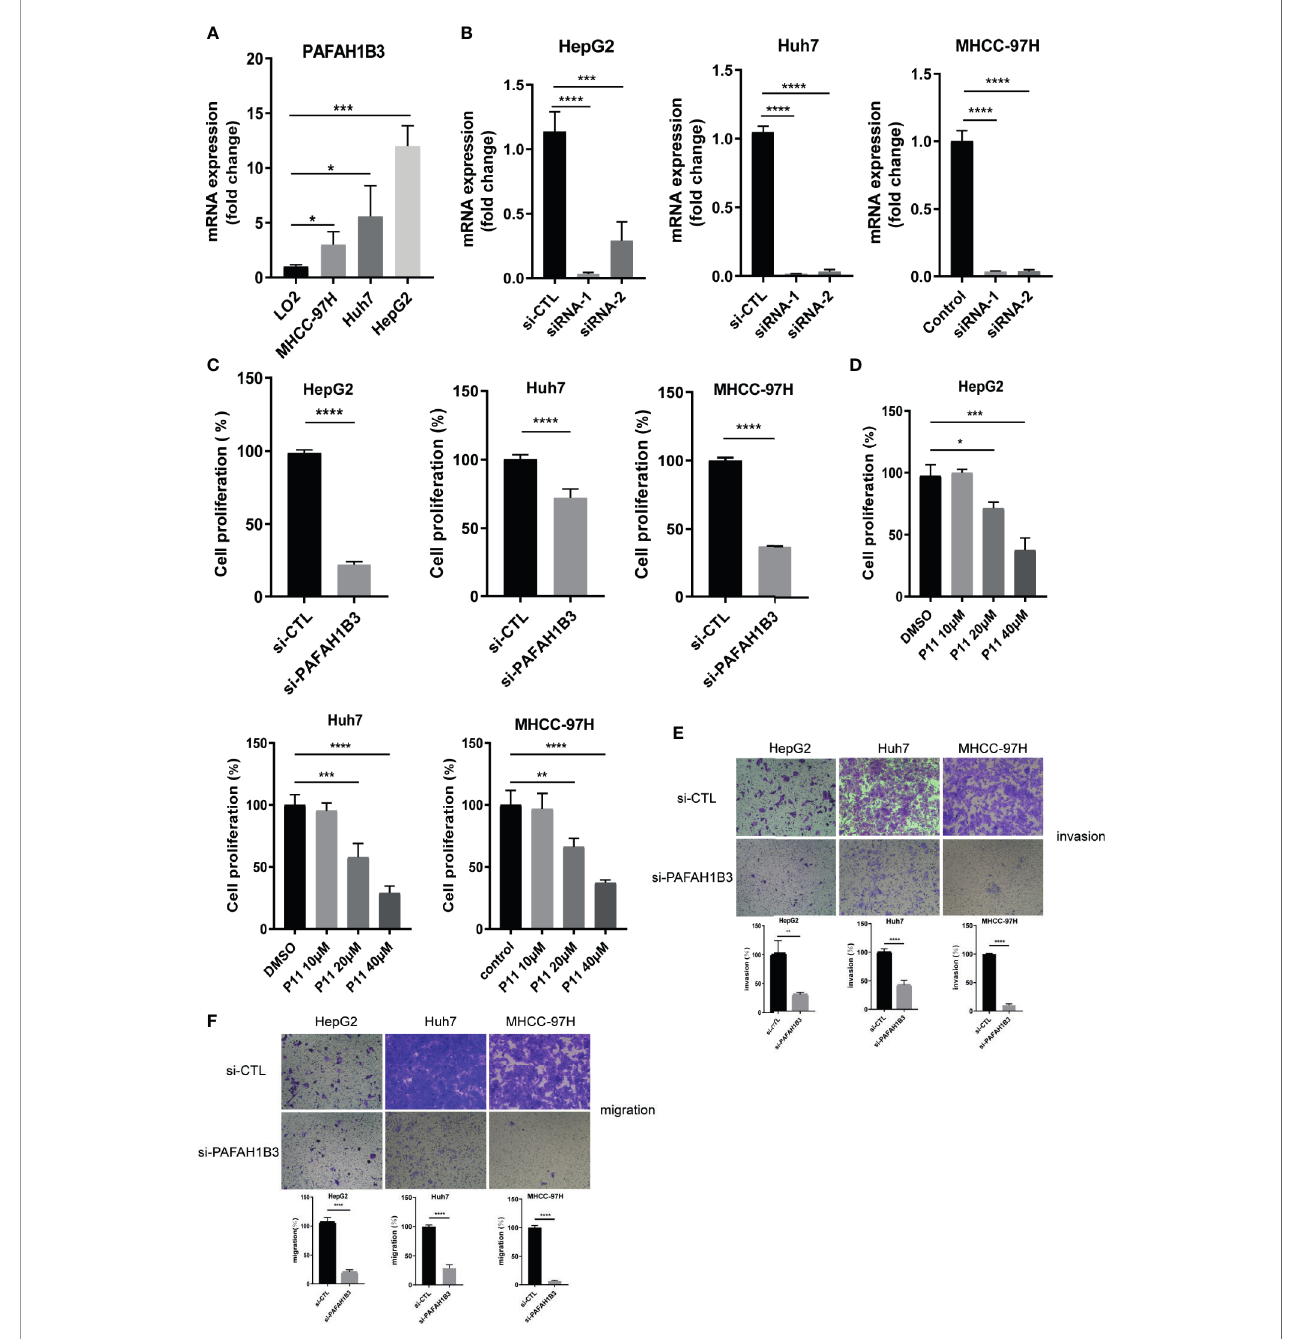
FIGURE 4 | High expression of PAFAH1B3 related to the proliferation and metastasis of HCC cells. (A) Levels of PAFAH1B3 mRNA in LO2, MHCC-97H, Huh7, and HepG2 cell lines. (B) Quantitation of the levels of PAFAH1B3 mRNA in HepG2, Huh7 and MHCC-97H cells by qRT-PCR after transfection for 48 h with different siRNAs targeting PAFAH1B3 (si-1 and si-2) or a control siRNA. (C) Proliferation of HepG2 and Huh7 cells after silencing PAFAH1B3 for 48 h (D) Proliferation of HepG2 and Huh7 cells after pharmacologic inhibitor of PAFAH1B3 for 48 h (E) Invasion assay. (F) Migratory assay. *p < 0.05; **p < 0.01; ***p < 0.001; ****p <